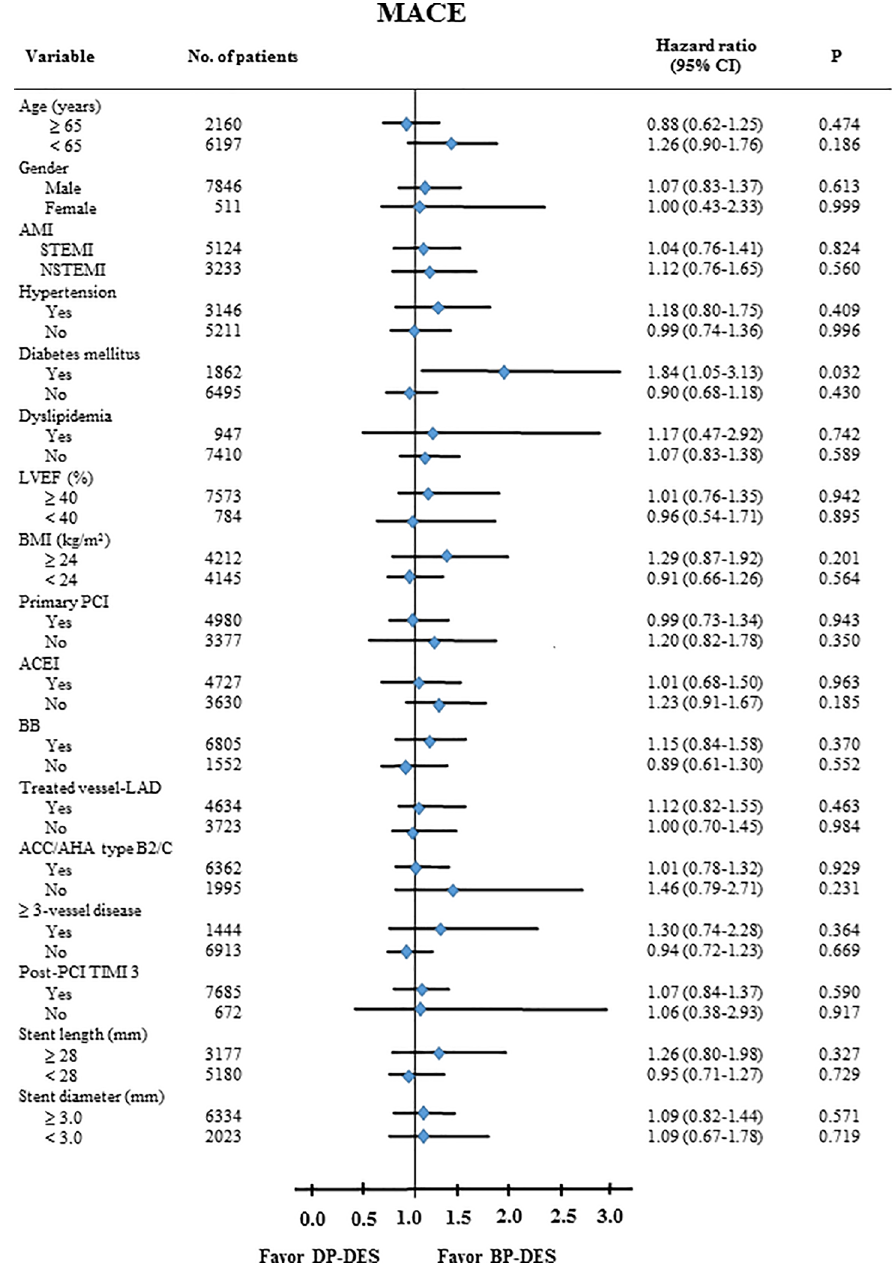
Fig 4. Subgroup analysis for MACE. MACE, major adverse cardiac events; AMI, acute myocardial infarction; STEMI, ST-segment elevation myocardial infarction; NSTEMI, non-ST-segment elevation myocardial infarction; LVEF,: left ventricular ejection fraction; BMI, body-mass index; ACEI, angiotensin converting enzyme inhibitors; BB, beta- blockers; LAD, left anterior descending; ACC/AHA, American College of Cardiology/American Heart Association; PCI, percutaneous coronary intervention; TIMI, Thrombolysis In Myocardial Infarction; DP-DES, durable-polymer drug-eluting stents; BP-DES, biodegradable-polymer DES.